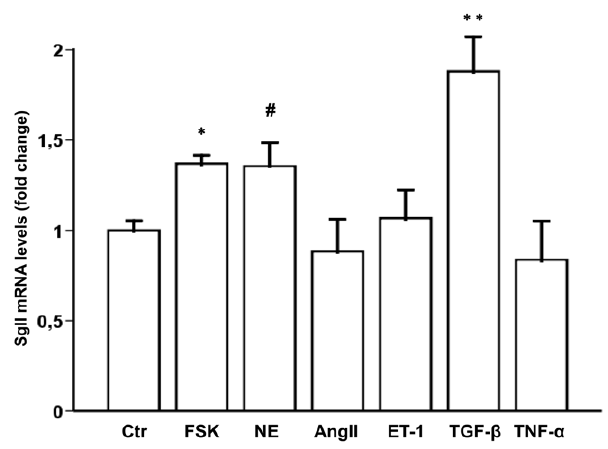
Figure 5. Regulation of cardiomyocyte SgII expression by important hormonal and paracrine factors in HF. SgII mRNA levels were measured by RT-qPCR after stimulating neonatal rat cardiomyocytes for 24 h with either PBS (Ctr, n=9), forskolin (FSK n=5), norepinephrine (NE, n=5), angiotensin II (AngII, n=4), endothe- lin-1 (ET-1, n=5), transforming growth factor- b (TGF- b , n=6), or tumor necrosis factor- a (TNF- a , n=6). SgII mRNA levels are presented as fold change 6 SEM vs. PBS-stimulated cells. **p , 0.001, *p , 0.01, # p , 0.05.